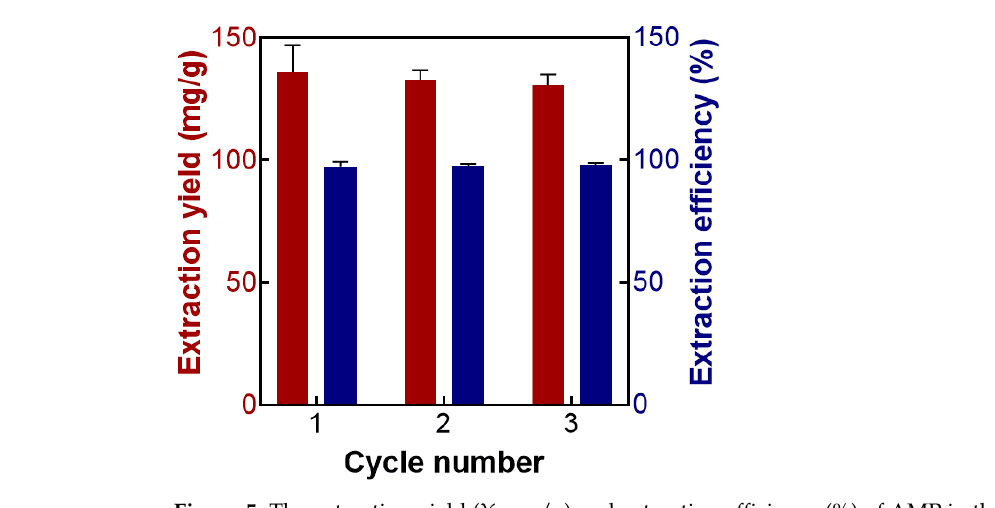
Figure 5. The extraction yield ( Y , mg/g) and extraction efficiency (%) of AMP in the recycling tests.